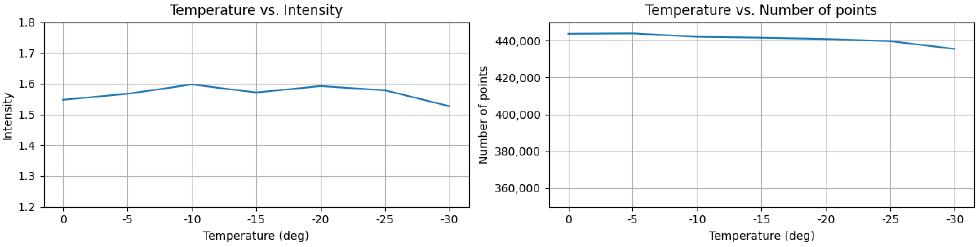
Figure 10. Example of low temperature test results. ( Left ) mean intensity versus ambient temperature ( Right ) number of points versus ambient